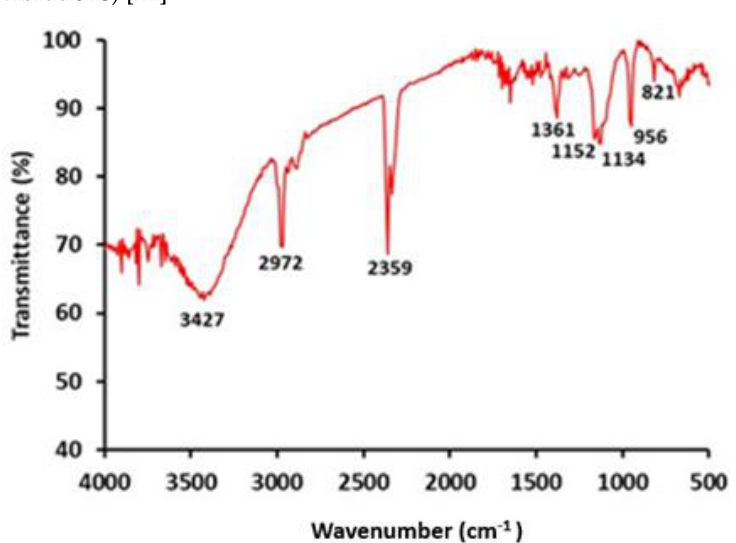
Figure 1. Fourier transform infrared spectroscopy (FTIR) spectrum of graphene oxide.